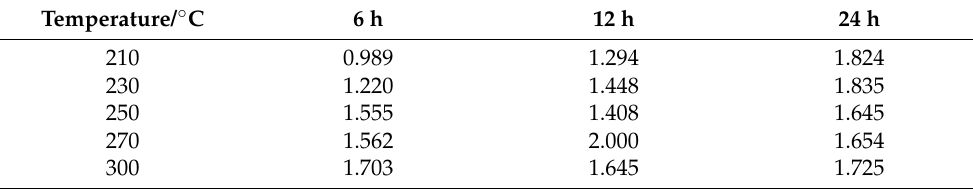
Table 3. Carbon content in retained austenite